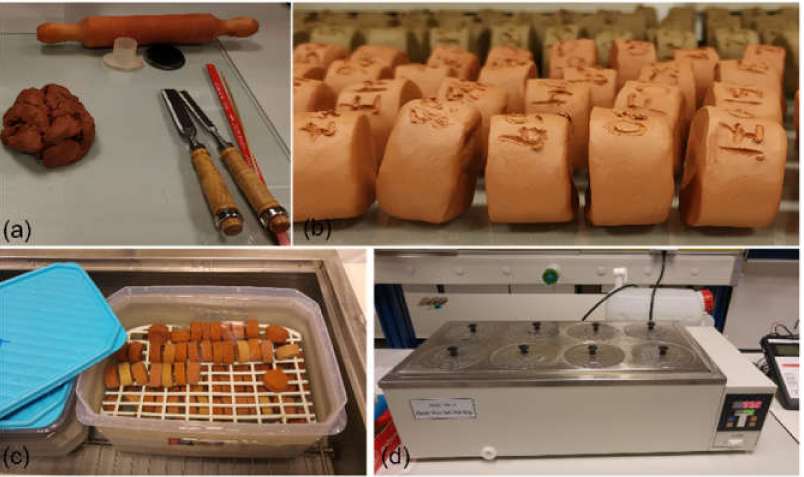
Figure 1. The manufacturing process of the test- and control-pieces before being fired. ( a ) the clay; ( b ) pieces before being fired; ( c ) test-pieces inside a seawater environment container; ( d ) the electric water bath containing the two environment containers. Table 1. List of 9 manufactured fabrics, combining different clays and firing temperatures, the number of test-pieces and control-pieces. PF, PT and AP are the abbreviations used for each kind of clay. Fabrics Clay Firing Temperature ( ◦ C)